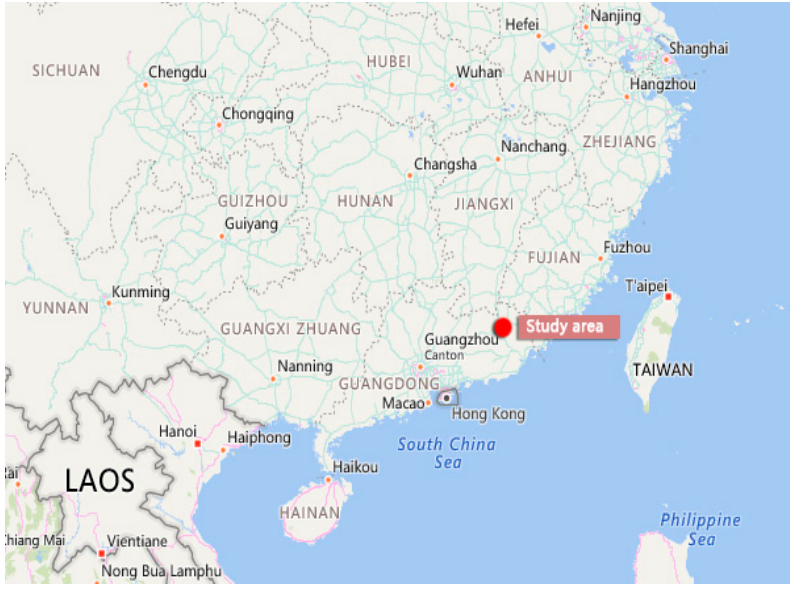
Figure 3. Study area (Meizhou city, Guangdong Province, China).